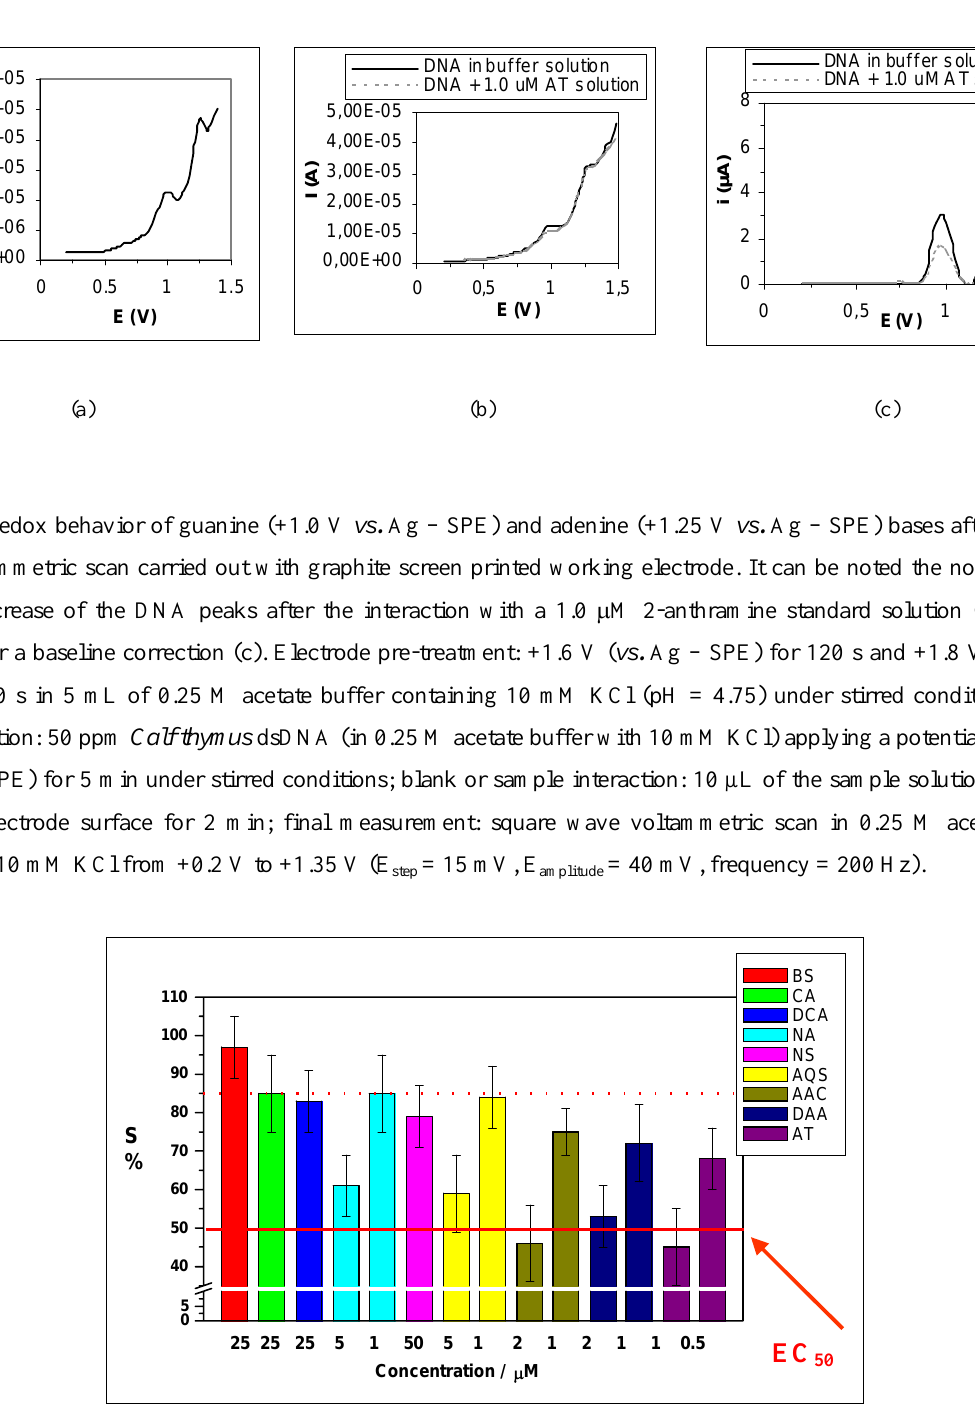
value: ecotoxic concentration required for a 50% decrease of 50